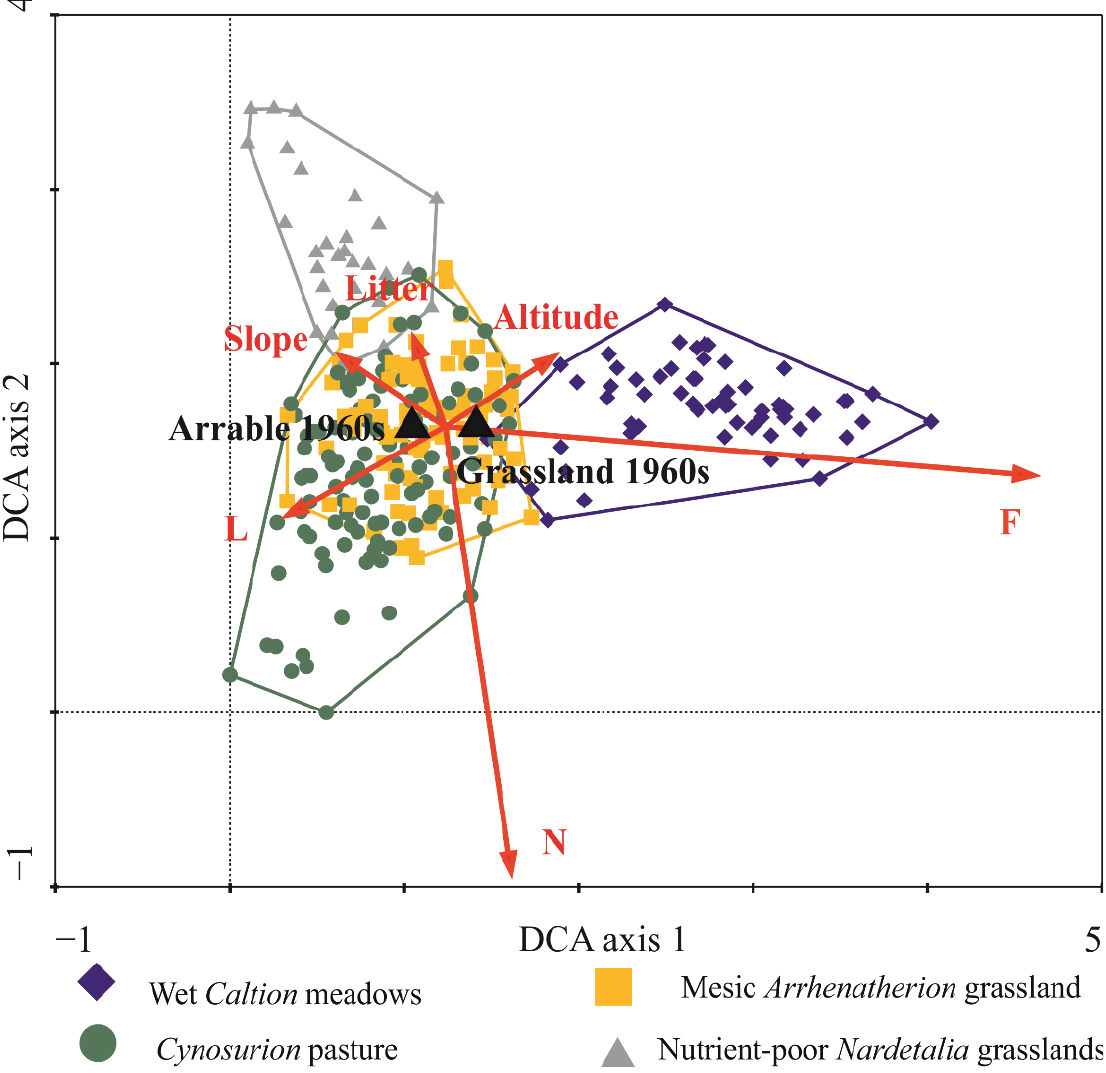
Figure 5. The Detrended Correspondence Analysis ( DCA) ordination diagram of 294 plots categorized by grassland type with environmental vectors as overlay. Eigenvalues were 0.506 and 0.276 for the first and second axis, respectively. Cumulative percentage variance of species data for the first and the second axis were 4.9% and 7.5%, respectively. Ellenberg Indicator Values: F-moisture, L-light, N-nutrients.